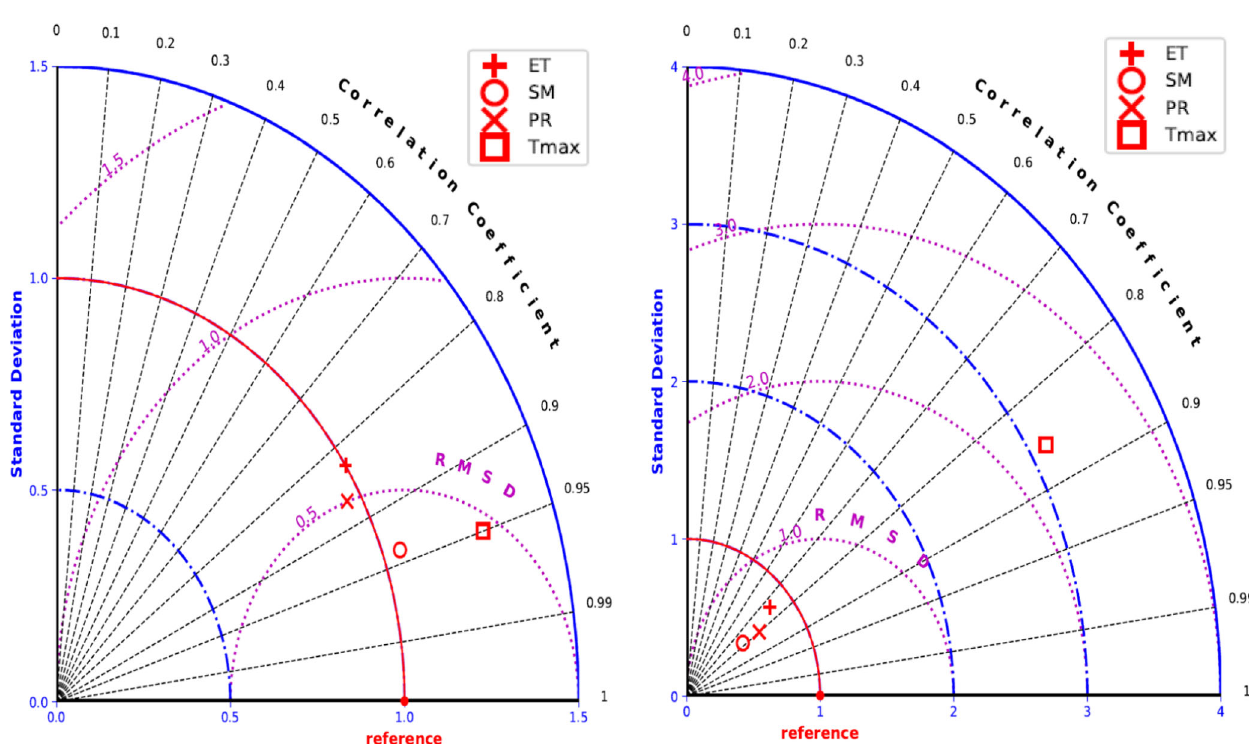
Fig. 2 Comparison of corrected and uncorrected model outputs using Taylor statistics. Taylor diagram showing statistics of annual-mean PR, T max , SM, and ET averaged over the Indian region based on the ( a ) corrected model outputs and ( b ) uncorrected model outputs. Taylor statistics represented using the correlation coef fi cient (black line), standard deviation (blue line), and root mean square deviation (purple line) with respect to observed data